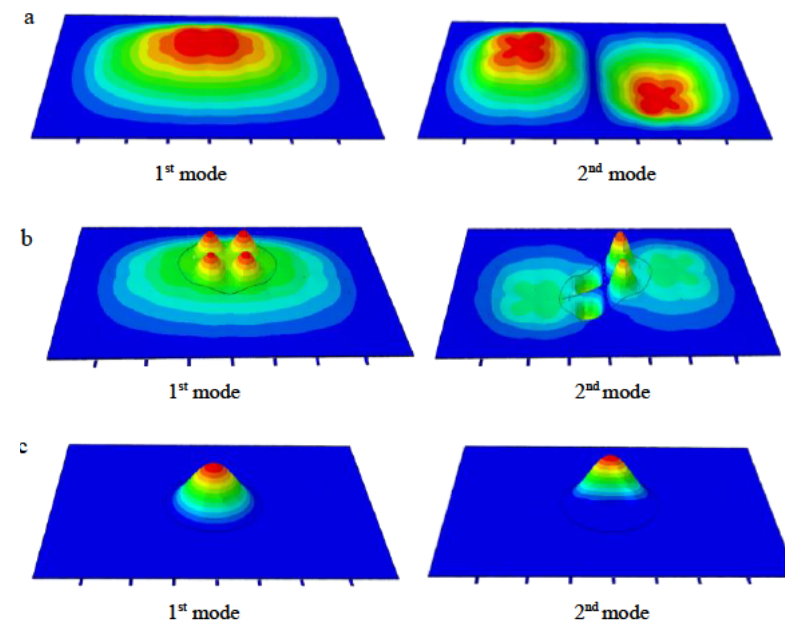
Figure 6: The first and second vibration modes: (a) initial model, (b) 10% debonding with contact (c) 10% debonding without